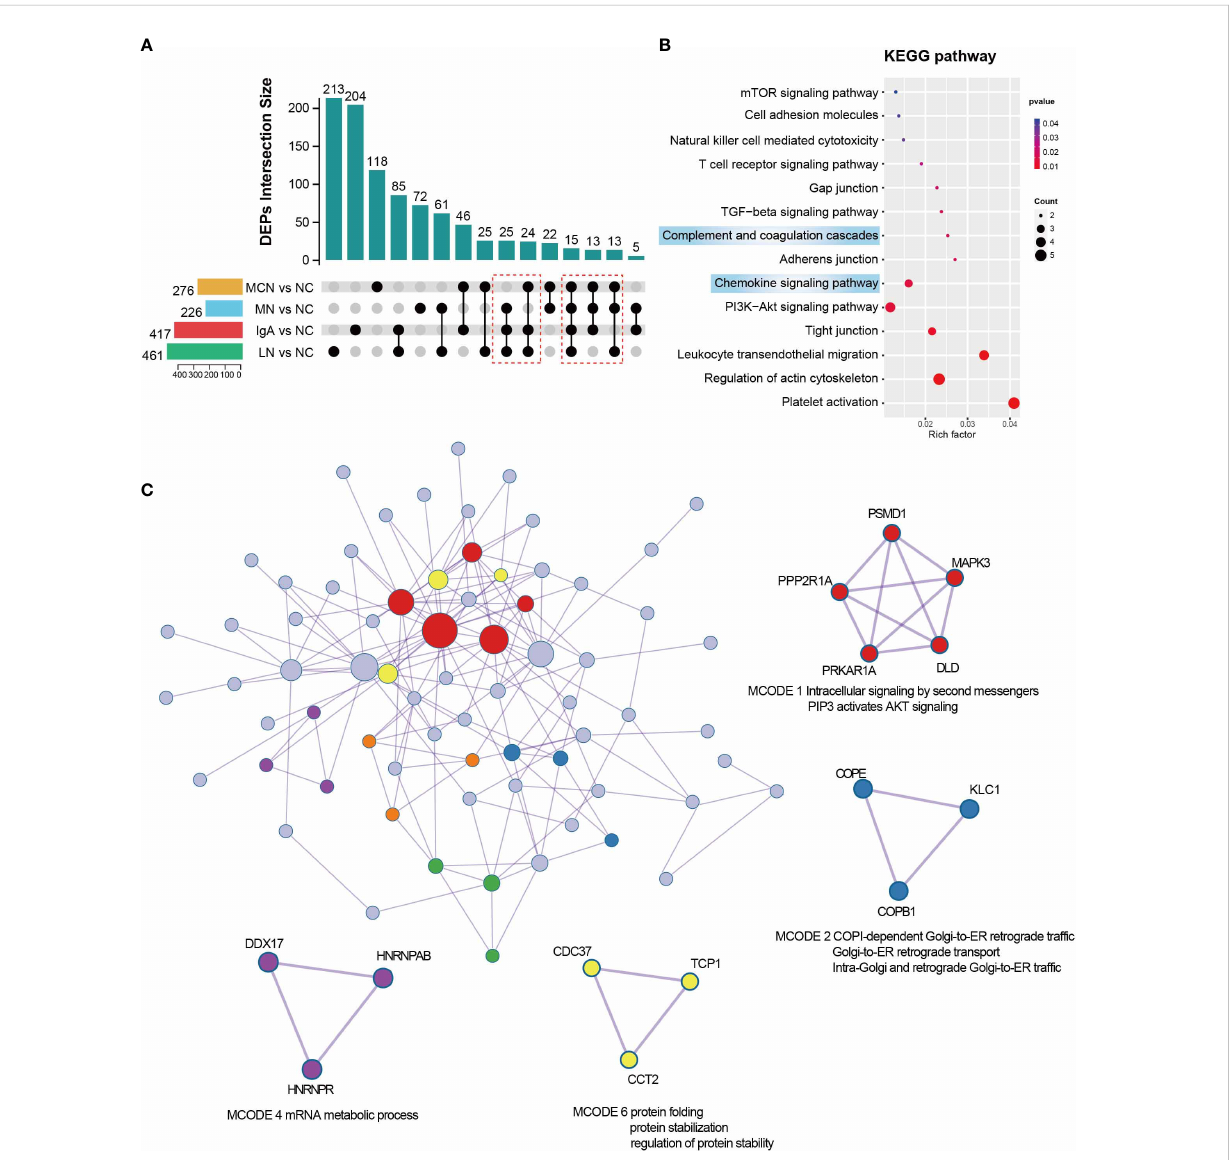
FIGURE 4 Function analysis of sharing DEPs in Each GNs Diseases. (A) UpSet plot showing the overlap proteins of DEGs between NC and four GNs disease groups. in the four GNs Disease. P value < 0.05 and |Log2FC| > 0.585 were used as screening criterion. The sharing DEPs existed in more than three of four GNs disease subgroups were marked with a red box and kept for downstream analysis. (B) Enriched pathway of 90 sharing DEPs in GNs diseases using KEGG analysis. (C) Protein-protein interaction network and MCODE components were automatically identi fi ed in Metascape. MCODE1,2,4, and 6 were marked in different colors and with functional